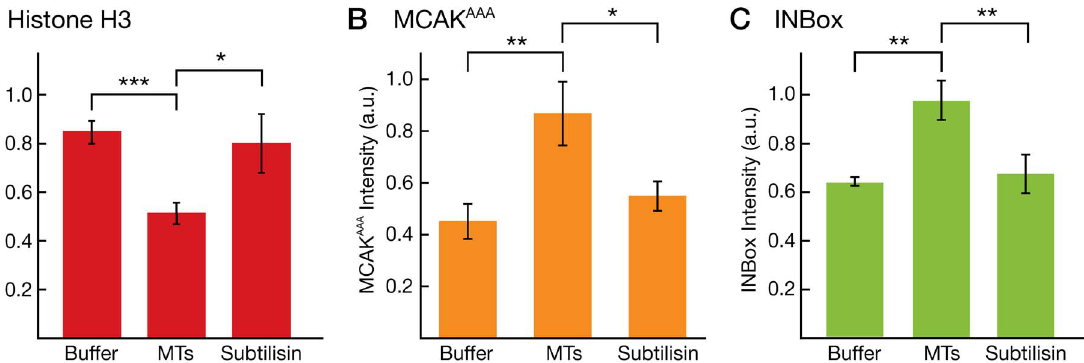
Figure 4. Disruption of Microtubule binding releases Aurora-B to soluble substrates. ( A ) Bar graph showing the normalized Histone H3 band intensity in c 32 P radiograms under three conditions: no microtubules (Buffer), paclitaxel-stabilized microtubules (MTs), and subtilisin-digested microtubule (Subtilisin). ( B ) Bar graph showing the normalized MCAK AAA band intensity in c 32 P radiograms under three conditions: no microtubules (Buffer), paclitaxel-stabilized microtubules (MTs), and subtilisin-digested microtubule (Subtilisin). ( C ) Bar graph showing the normalized INBox motif band intensity in c 32 P radiograms under three conditions: no microtubules (Buffer), paclitaxel-stabilized microtubules (MTs), and subtilisin-digested microtubule (Subtilisin). Note that the Histone H3, MCAK AAA , and INBox band intensities were normalized independently, so the data cannot be used to compare the absolute levels of phosphorylation across the different substrates.